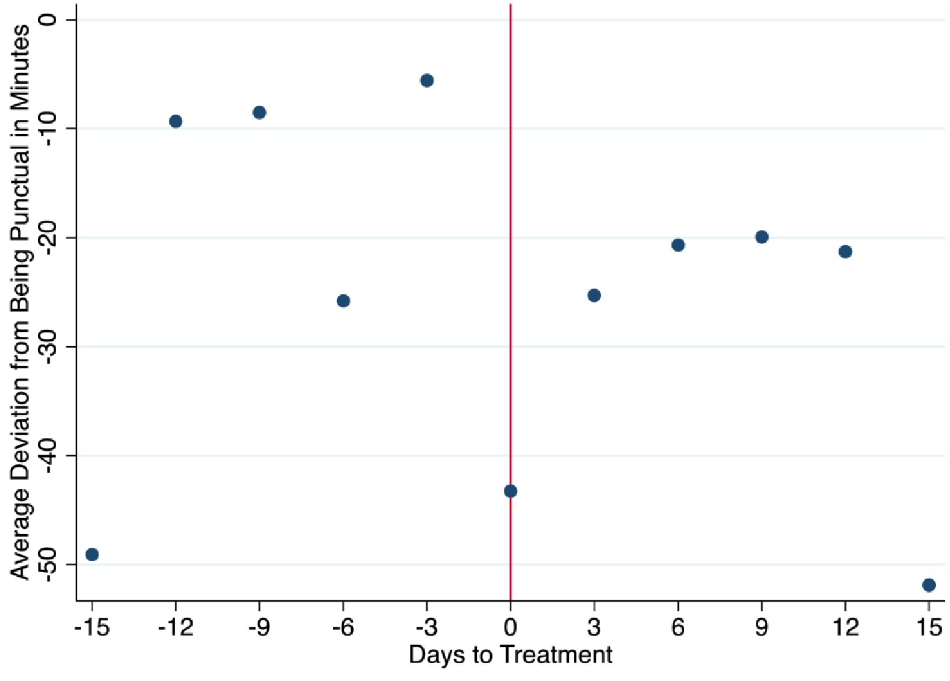
Fig 5. Before and after averages of